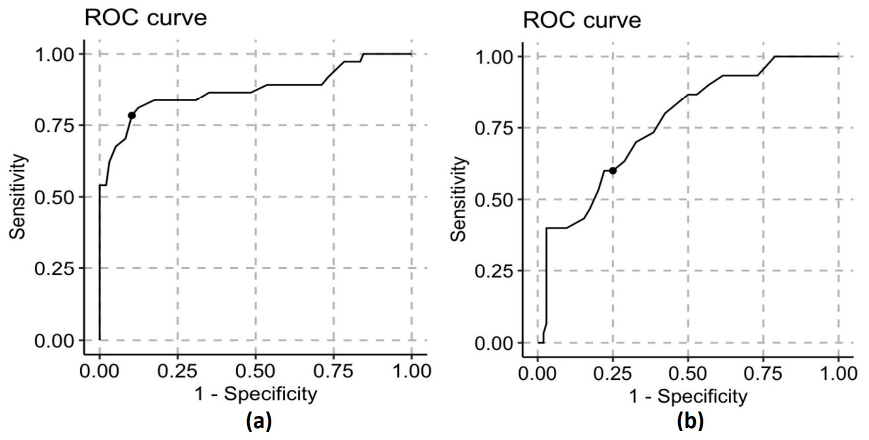
Figure 4. ROC curve analysis for DHM samples in category A ( a ) and category C ( b ). The AUC for Category A was 0.87; for Category C, it was 0.76.